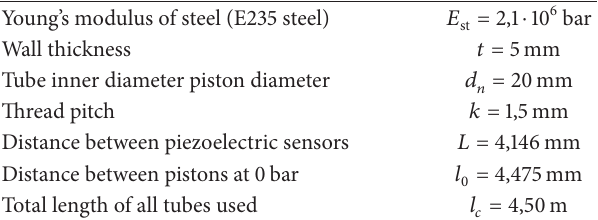
Table 1: Important parameters of the measuring